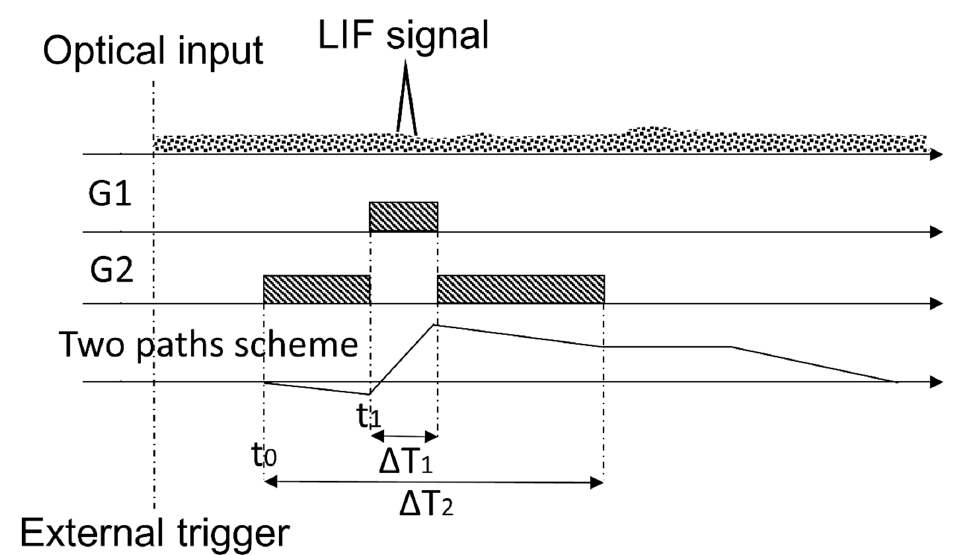
Figure 3. Gates scheme and their relations, as implemented in the CIM unit. In figure, the shaded rectangles represent the temporal intervals when each gates G1 and G2 are active; the triangle schematizes the LIF signal and the dotted area on the top is a schematic illustration of the background signals. The continuous line in the last subplot represents the optical input (first plot) integrated with negative gain -1⁄m in the time interval G2 and with unity gain in the time interval